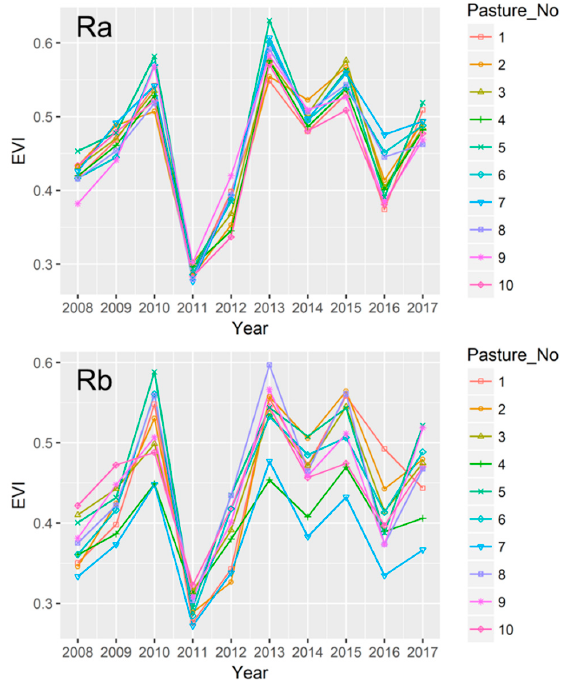
Figure 9. Growing season average EVI from Landsat 7 for paddocks in rotational